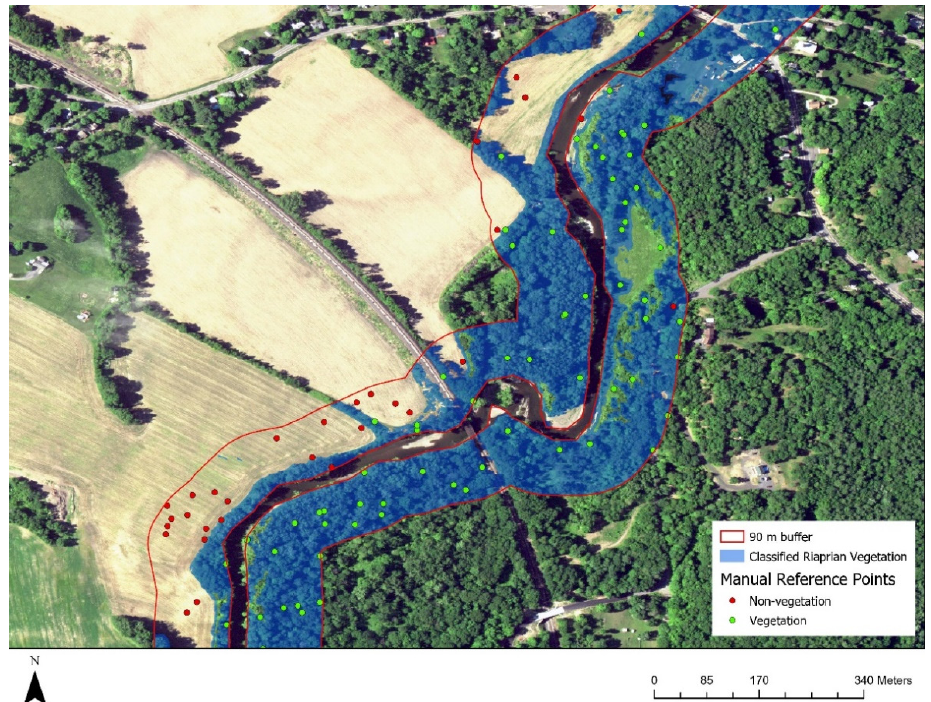
Figure 3. Example results of manual vs. automatic delineated river channel boundary. Background image is 2015 NAIP. Center of map is located near Town of Stuyvesant Falls, New York State, United States.